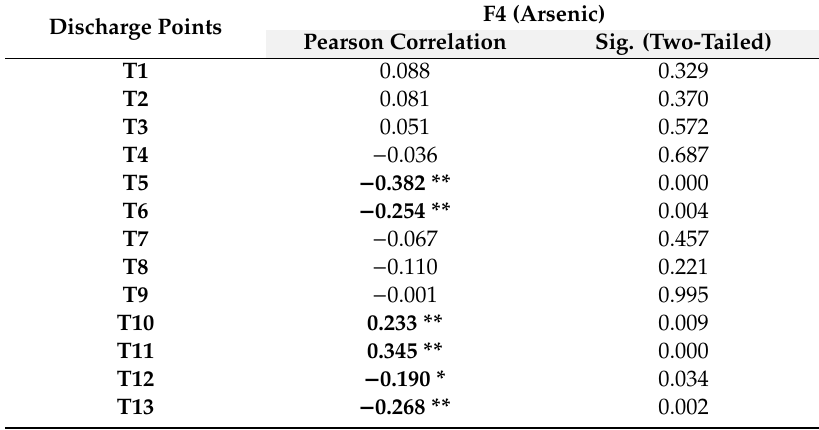
Table 4. Correlations of As with respect to the position of natural thermal springs present on Bagnoli bay seabed. Significant correlations are highlighted in bold. The number of data are